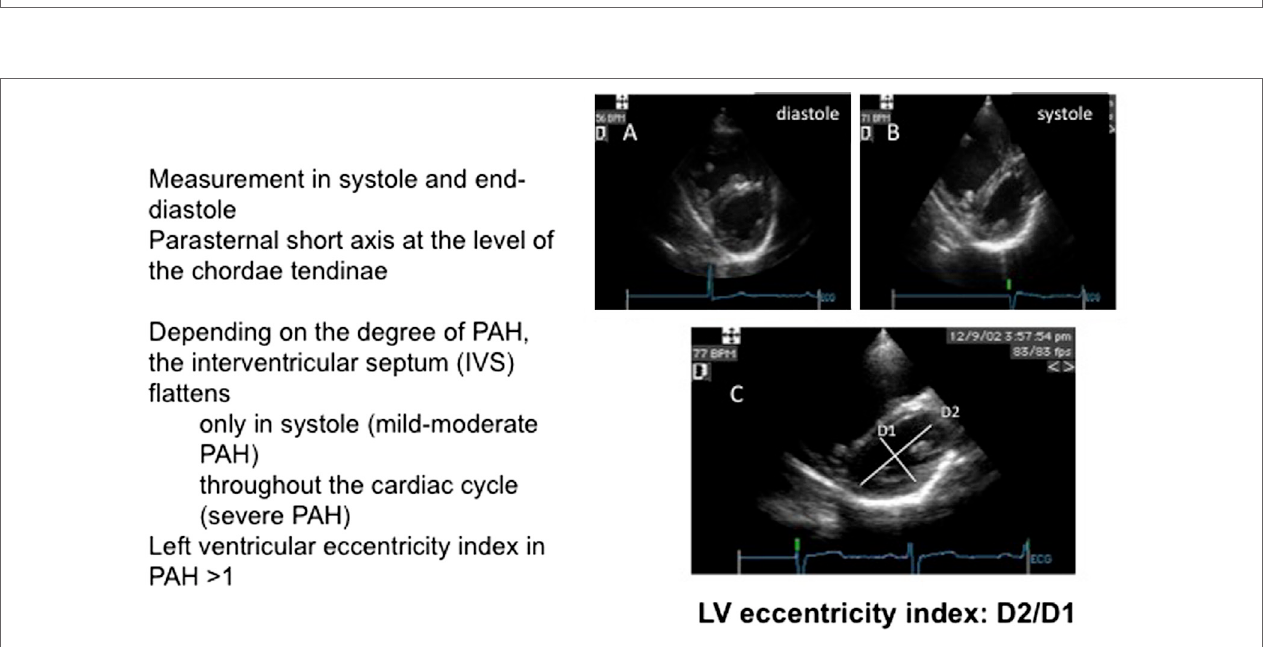
FigURe 4 | Right ventricular outflow tract Doppler evaluation. (A) Short axis view with the Doppler beam through the right ventricular outflow tract. (b) Pulmonary blood flow envelope. AT, acceleration time; ET, ejection